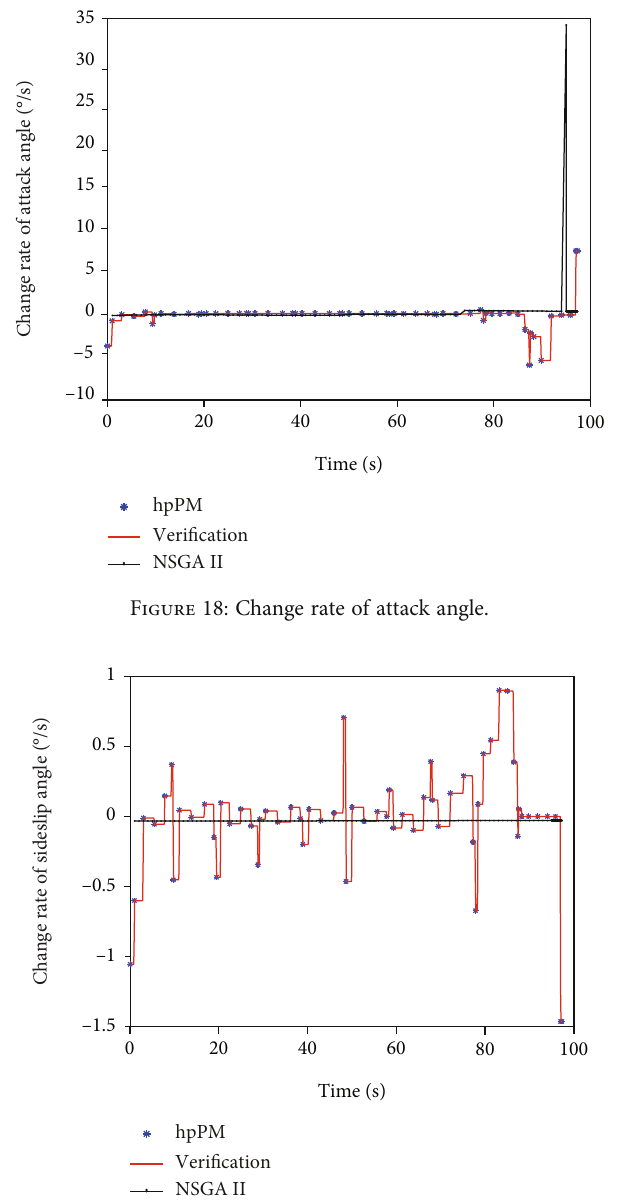
Figure 19: Change rate of sideslip angle.